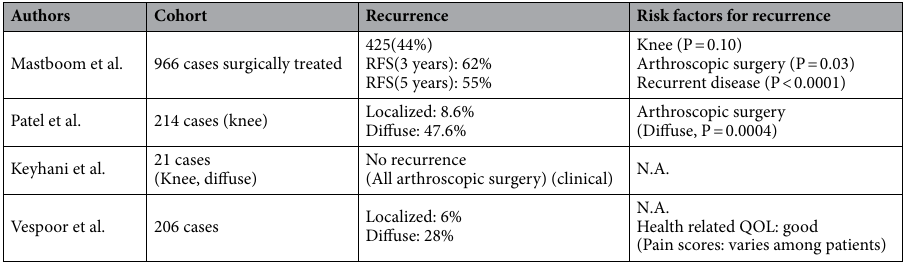
Table 5. Recent studies associated with the results of the present study. (i) Mastboom 30 . (ii) Patel 26 . (iii) Keyhani 31 . (iv) Verspoor 32